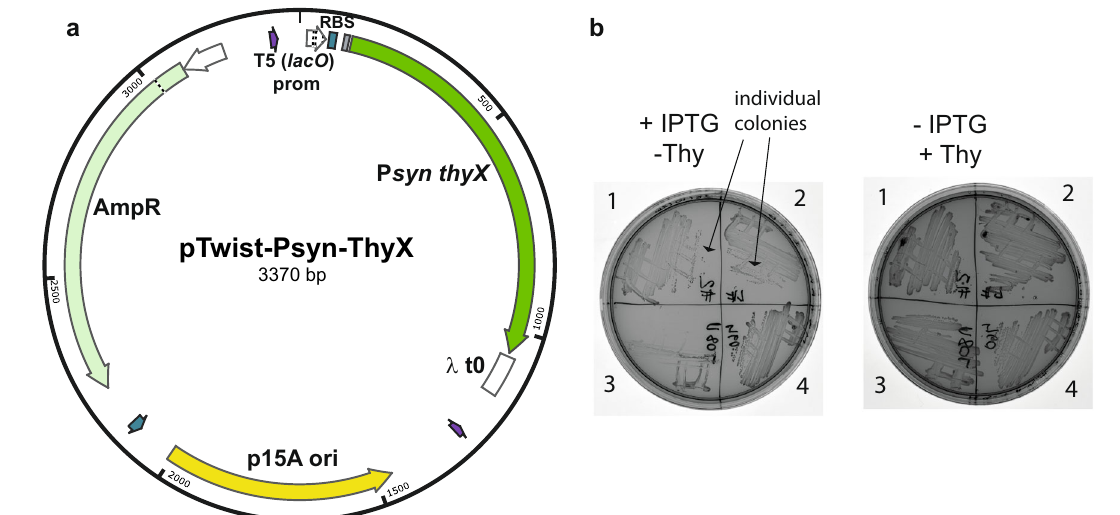
Fig. 6 | Genetic complementation experiments using Psyn thyX. a Map for the synthetic plasmid pTwist-Psyn-ThyX. Transcription of the Psyn thyX gene is under the control of a synthetic T5 promoter carrying lacO . An ampicillin resistance marker and a p15A replication origin are integrated, as well as a lambda t0 termi- nator. b Interdomain complementation assay using Psyn thyX . The ability of Psyn thyX to permit thymidine-independent growth of E. coli thymidine-auxotroph